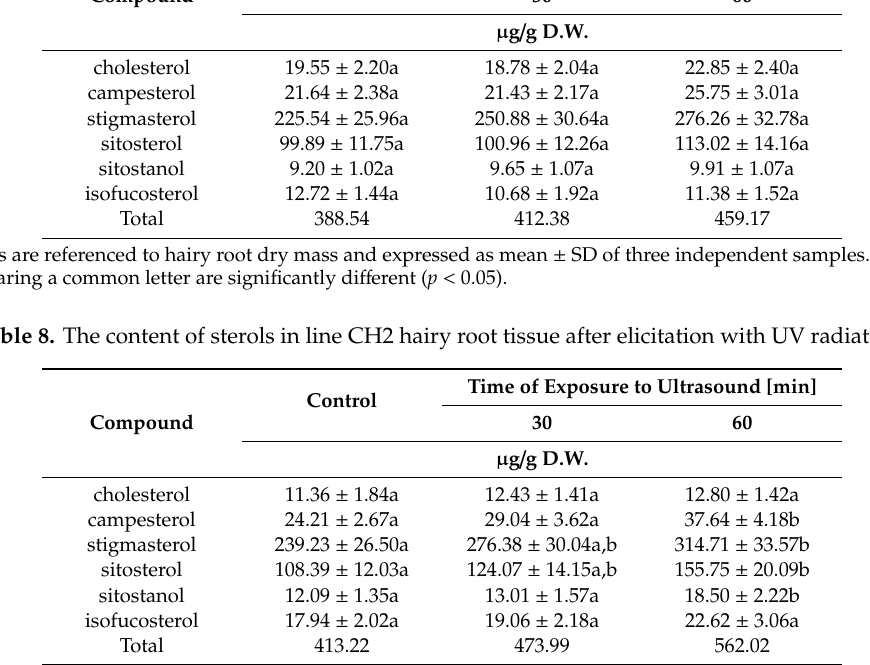
Table 7. The content of sterols in line CC16 hairy root tissue after elicitation with UV radiation. Time of Exposure to Ultrasound [min] Control 30 Compound µ g / g D.W.